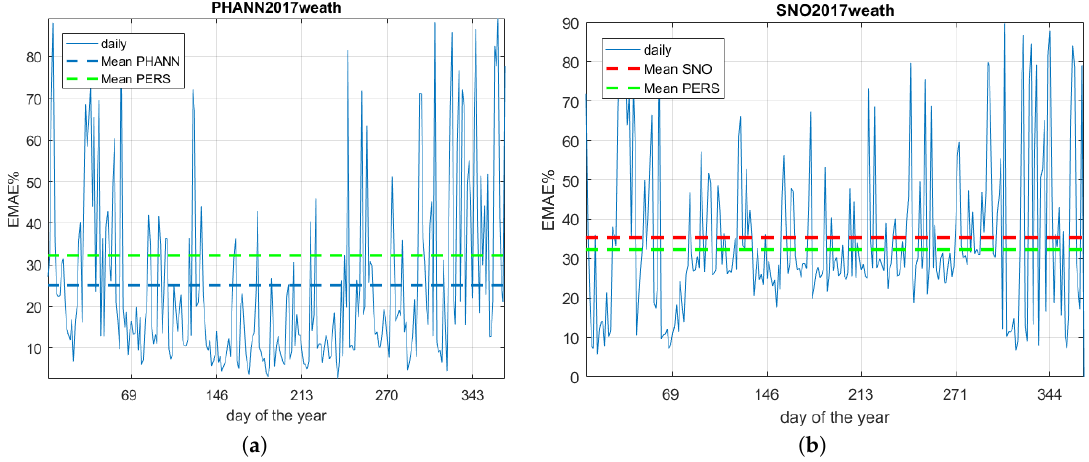
Figure 9. Daily EMAE% for 2017 using weather forecasts: ( a ) PHANN; and ( b ) SNO based